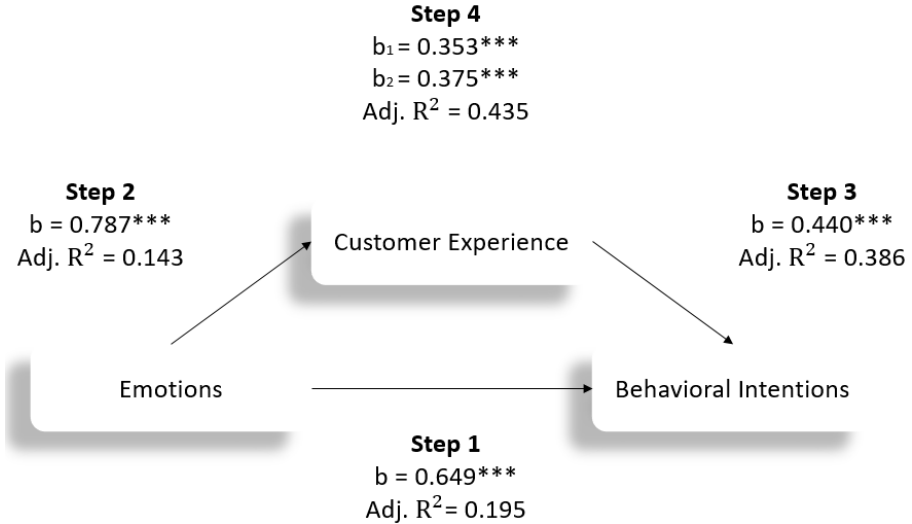
Figure 2. Regression analyses results. *** the significance is lower than 0.001